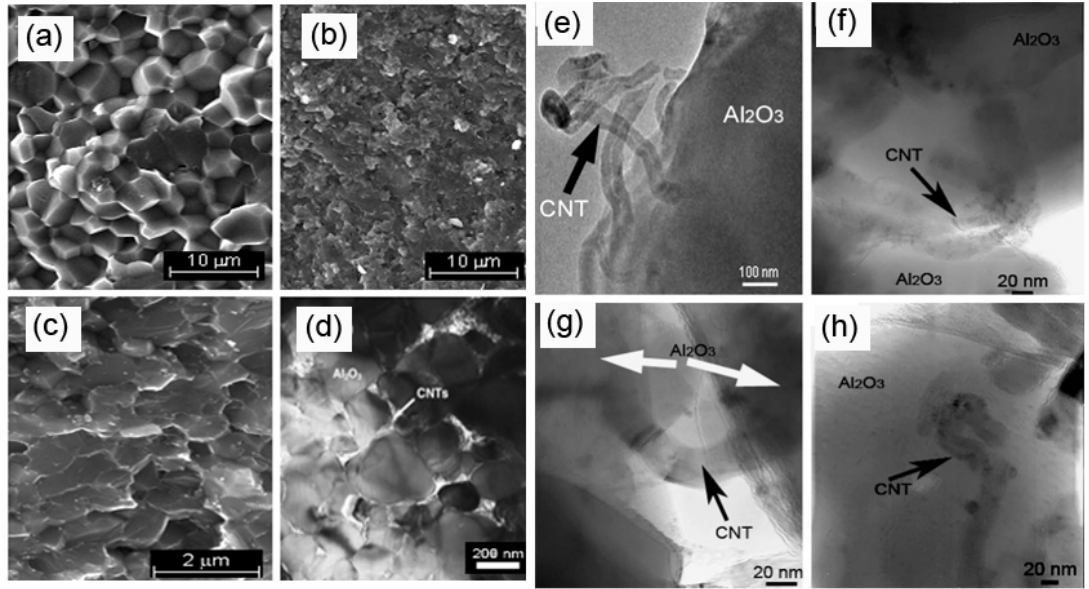
Figure 2. Structural features of ( a ) Monolithic Al 2 O 3 showing large grains with inter-granular fracture; ( b ) CNTs/Al 2 O 3 nanocomposites with fine grains; ( c ) Trans-granular fracture mode in CNTs/Al 2 O 3 nanocomposites; and ( d ) Single-walled (SW)CNTs at grain boundary of Al 2 O 3 matrix. TEM images exhibiting the CNT–ceramic interactions ( e ) Multi-walled (MW)CNTs (black arrow) showing their morphology in nanocomposite; ( f ) A single MWCNT existing at grain boundary; ( g ) in porosity and ( h ) Embedded within a single ceramic grain. Adapted from References [32] and [66] with permissions. Copyright 2010, Elsevier